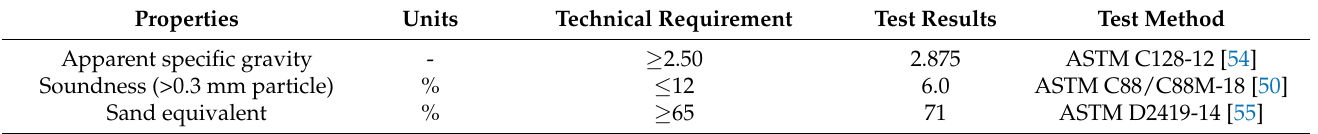
Table 4. Technical requirements for fine